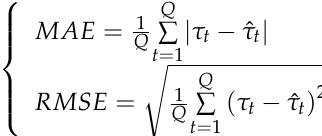
Table 1. Comparison of time-delay prediction evaluation metrics for different prediction algorithms. Time-Delay Prediction Methods RMSE MAE Cycle Forecast Time (ms) BP Neural Networks 0.0242 0.0688 5.47 RBF Neural Networks 0.0188 0.2045 0.94 Improving PSO-RBF networks 0.0105 0.0383